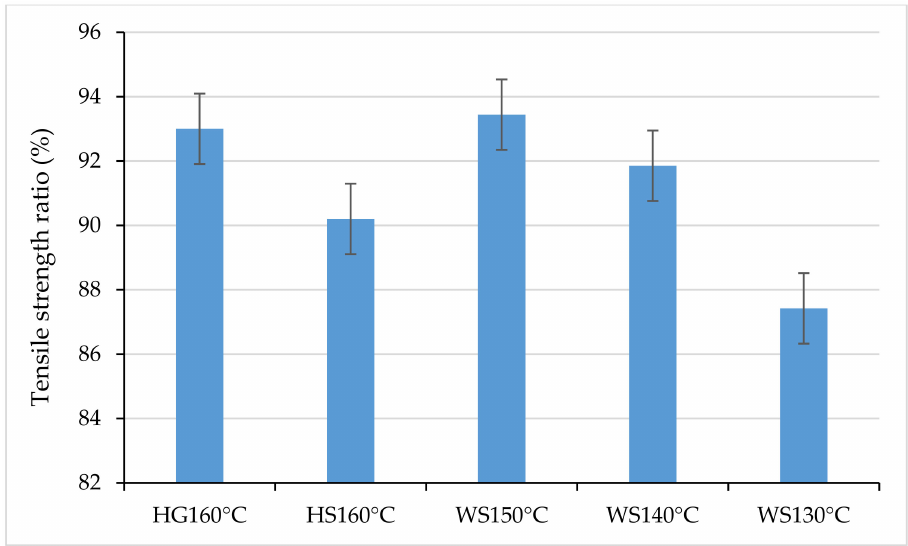
Figure 7. Tensile strength ratio and the standard error bars of the